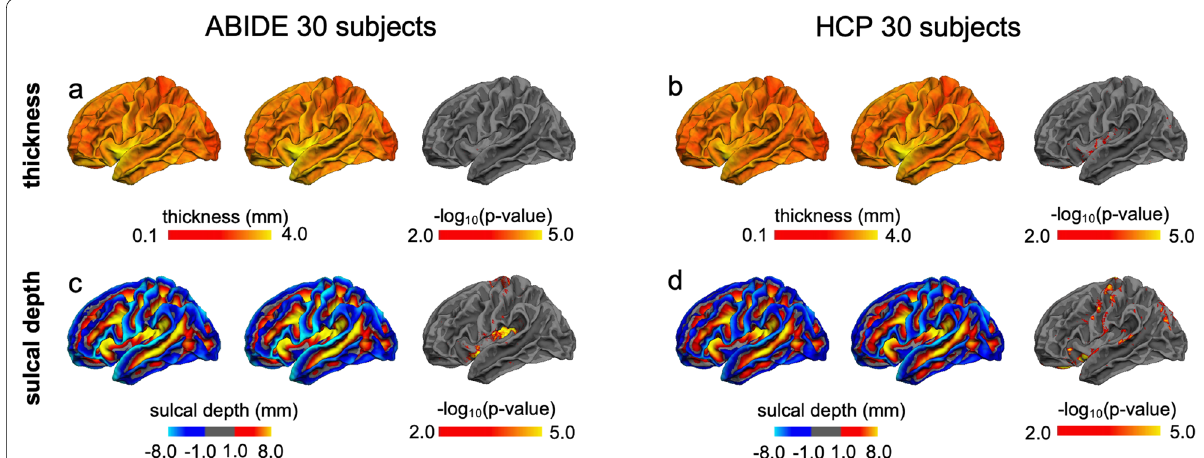
Fig. 6 Surface morphometries measured in unseen datasets. To examine if FastCSR is generalizable to unseen datasets, we applied this method to the previously unseen ABIDE-II dataset with T1w images at 1.0-mm resolution and the HCP dataset with 0.7-mm resolution images. These data were also processed using the FreeSurfer pipeline. Cortical thickness and sulcal depth were estimated. a The average cortical thickness maps obtained from FreeSurfer (left) versus FastCSR (right) in the ABIDE-II dataset are similar, with only 0.07% of the vertices demonstrating significant difference (two-tailed paired t -tests, p < 0.01, FDR corrected). b For the HCP dataset, the average cortical thickness maps derived from FreeSurfer and FastCSR are also similar, with only 2.16% of the vertices showing significant difference (two-tailed paired t -tests, p < 0.01, i.e., c The positive values in the sulcal depth maps indicate sulci (warm colors) and negative values indicate gyri (cool colors). For the ABIDE-II dataset, 2.44% of the vertices showed significant differences between the FreeSurfer and FastCSR method. Differences were mainly distributed in the insular cortices, the precentral gyrus, and the medial orbitofrontal cortices. d For the HCP dataset, 5.87% of the vertices showed significant difference in sulcal depth between FreeSurfer and FastCSR